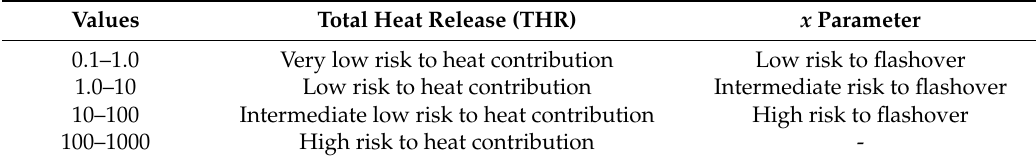
Table 1. Petrella’s evaluation system.